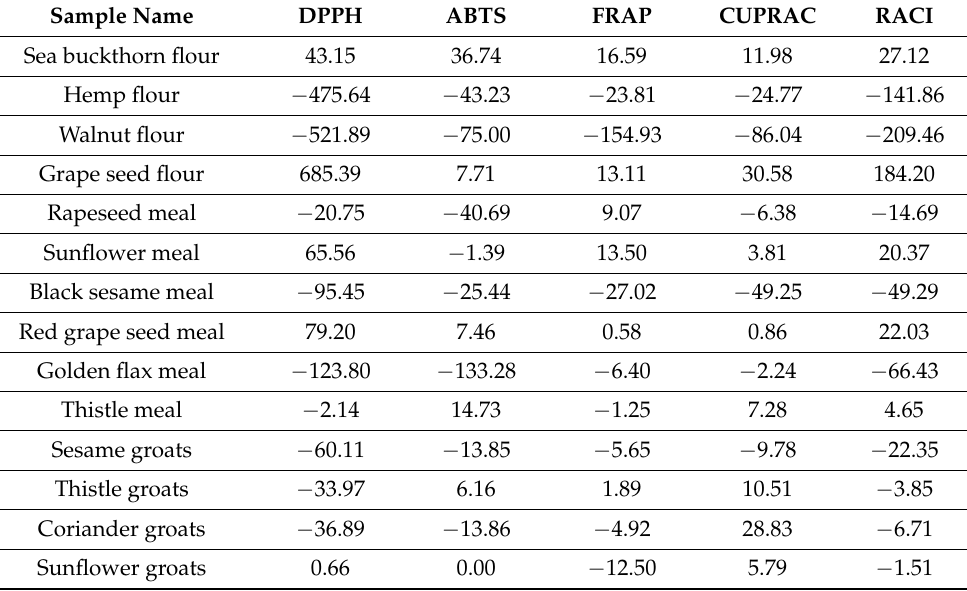
Table 4. Standard scores of antioxidant capacity and RACI for the analyzed